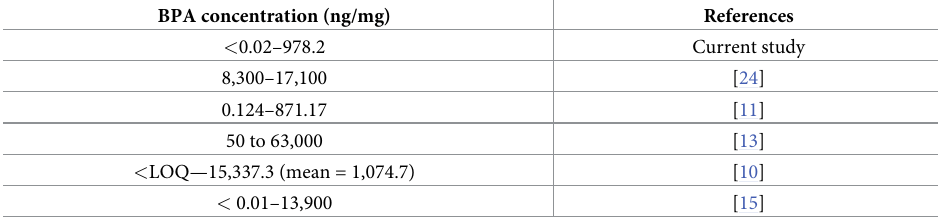
Table 2. BPA concentrations in thermal paper receipts from varying sources in current study and various global